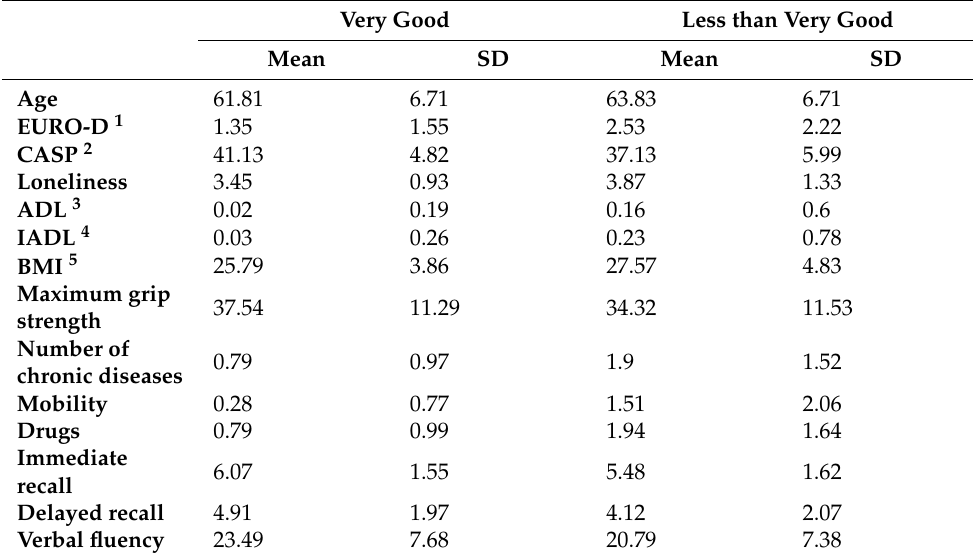
Table 4. Overview of mean values by self-perceived health rating.